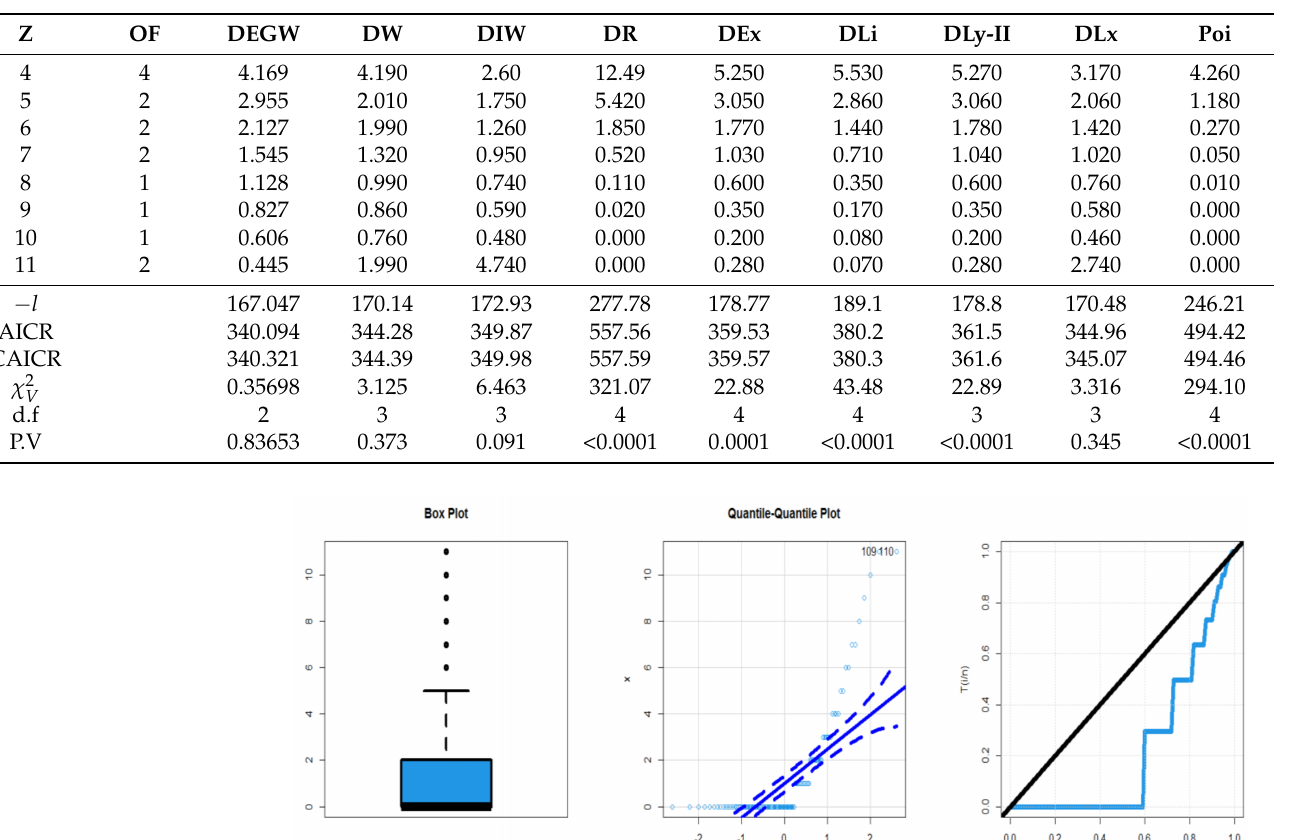
Figure 11. Boxplot, Q-Q plot, and TTT plot for dataset III.